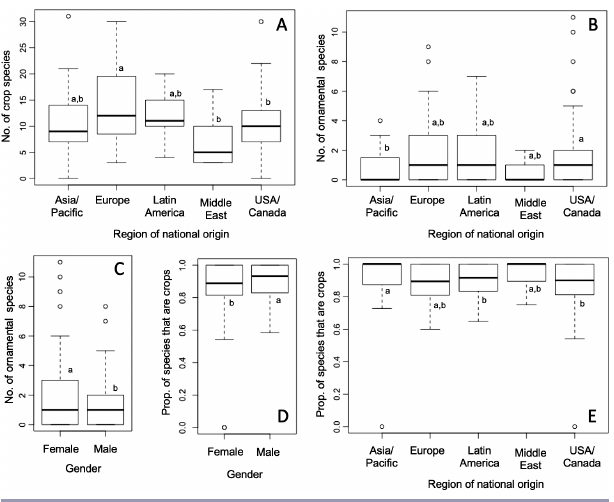
Fig. 2 . Significant predictors of crop (A) and ornamental plant richness (B, C) and the proportion of plant species that are crops (D, E) reported by gardeners in urban gardens in the California central coast. In the box plots, the thick line is the median, the box limits are the 25% and 75% percentiles, whiskers show 1.5 times the interquartile range, and points are outliers. Small letters show differences between groups. Sample size for each group listed in Table 1.